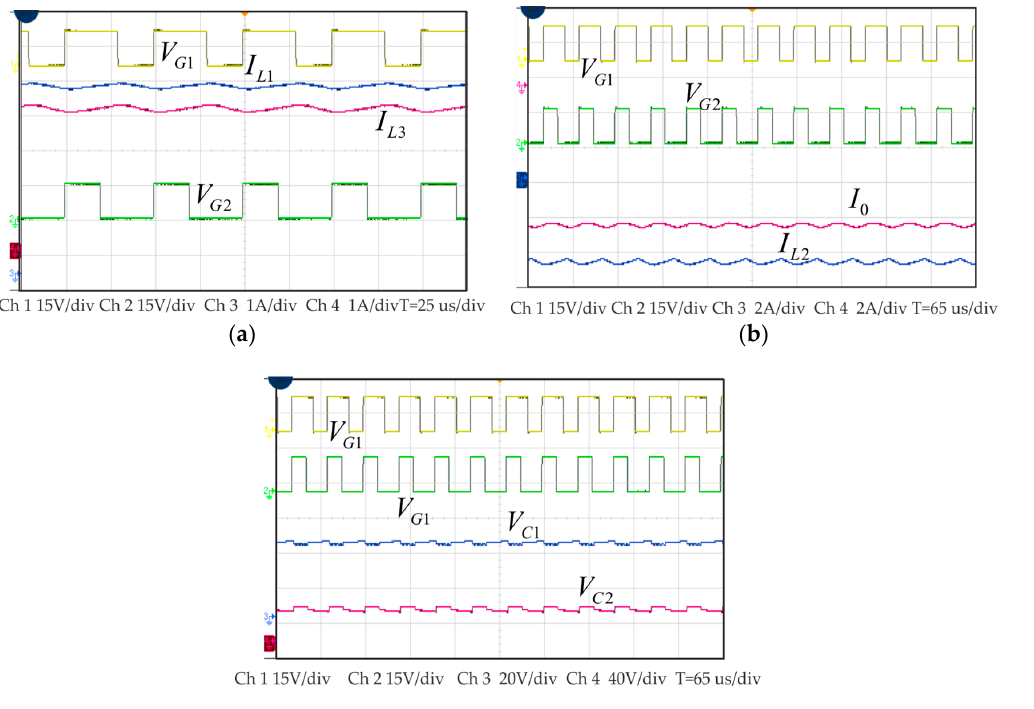
Figure 16. Various voltage and current measurements from experiments during Mode 2 with both sources: ( a ) Gate pulses of both switches and inductor currents through L 1 and L 3 (CH 1–4); ( b ) Gate pulses of switches , inductor currents through L 2 and L 0 (CH 1–4); ( c ) Gate signals of S 1 and S 2 , and capacitor voltages across C 1 and C 2 (CH 1–4).